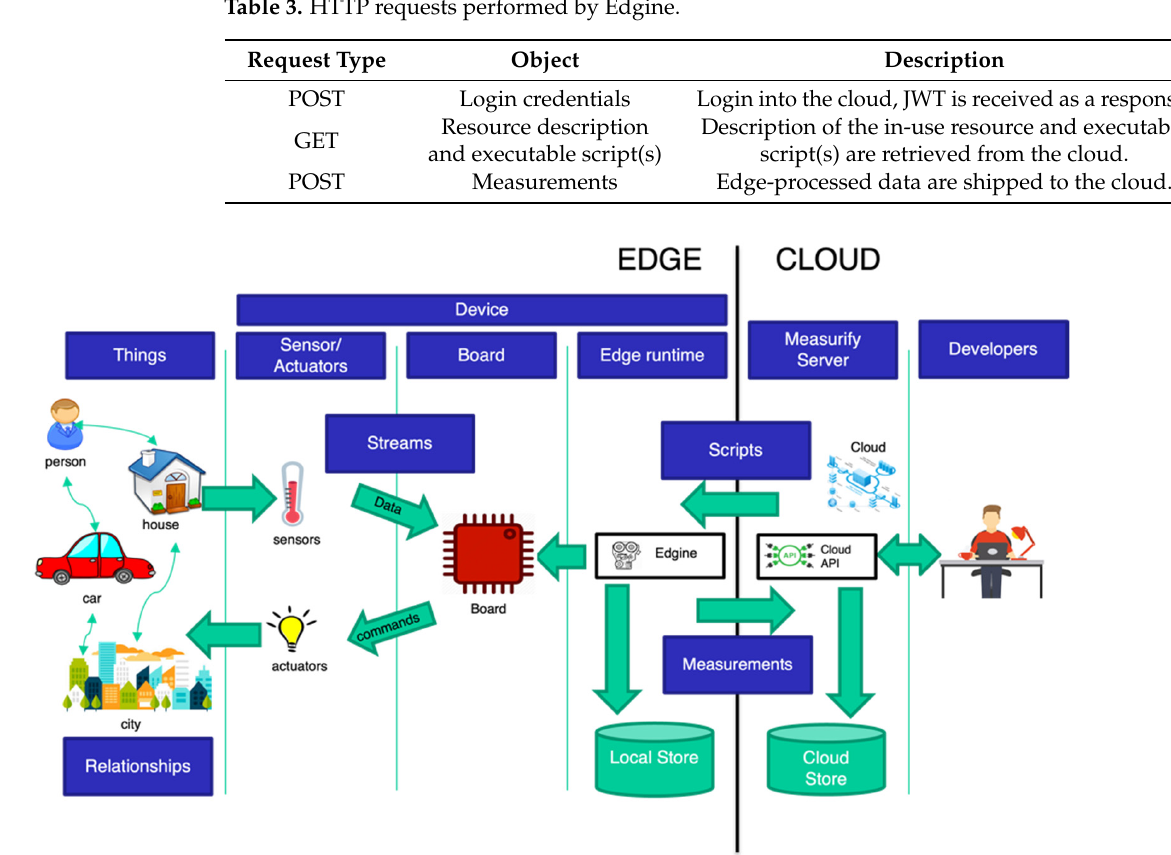
Figure 3. Edgine–Measurify overall end-to-end system architecture.